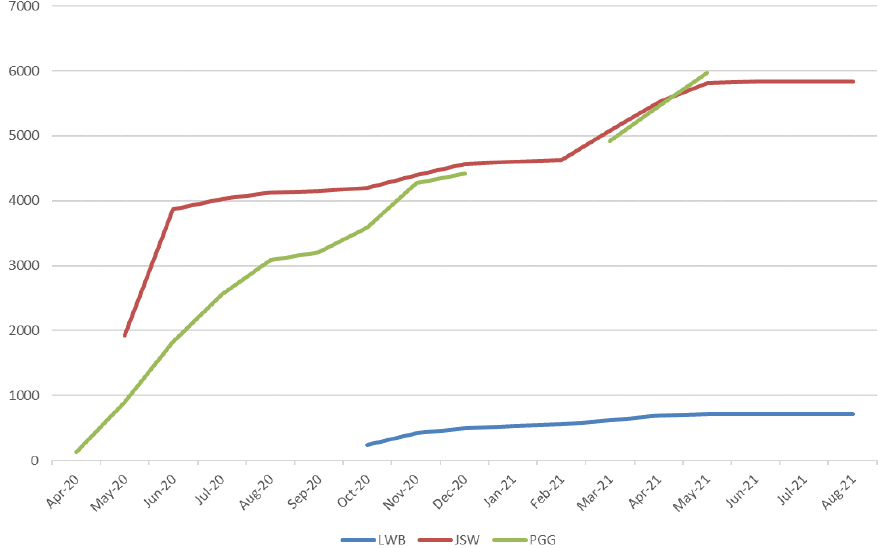
Figure 1. Comparison of infection models in three selected coal companies in Poland in the period from April 2020 to August 2021.